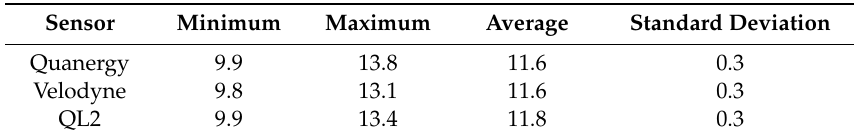
Table 7. Digital terrain model (DTM) elevation (m) statistics from Quanergy M8, Velodyne HD32-L, and QL2 LiDAR